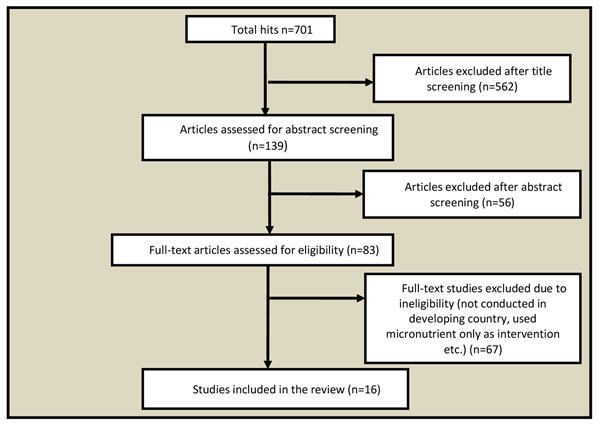
Search flow diagram